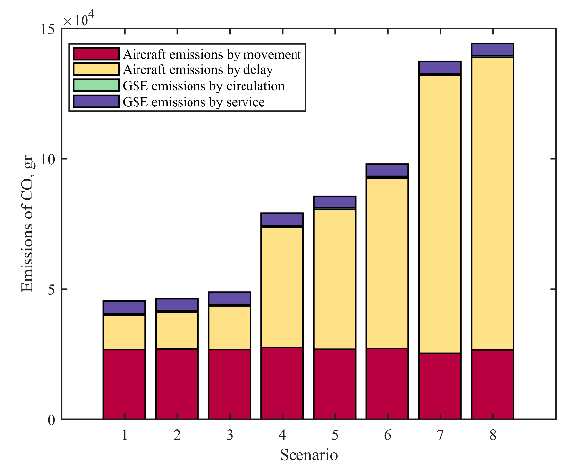
Figure 7. CO emissions per group and process.